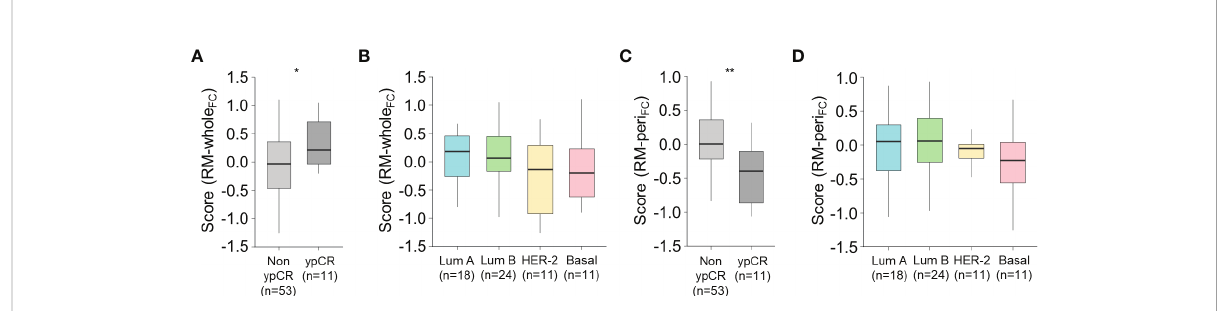
FIGURE 6 Association between the score from the radiomic models and the response to neoadjuvant chemotherapy. (A, B) The score obtained from RM- whole FC according to the pathologic response to neoadjuvant chemotherapy (A) and molecular subtype (B) . (C, D) The score obtained from RM-whole FC according to the pathologic response to neoadjuvant chemotherapy (C) and molecular subtype (D) . Statistical analyses were performed using Student ’ s t -test (A, C) and one-way ANOVA with post-hoc Tukey ’ s test (B, D) . * P < 0.05, ** P < 0.01. ypCR, pathologic complete